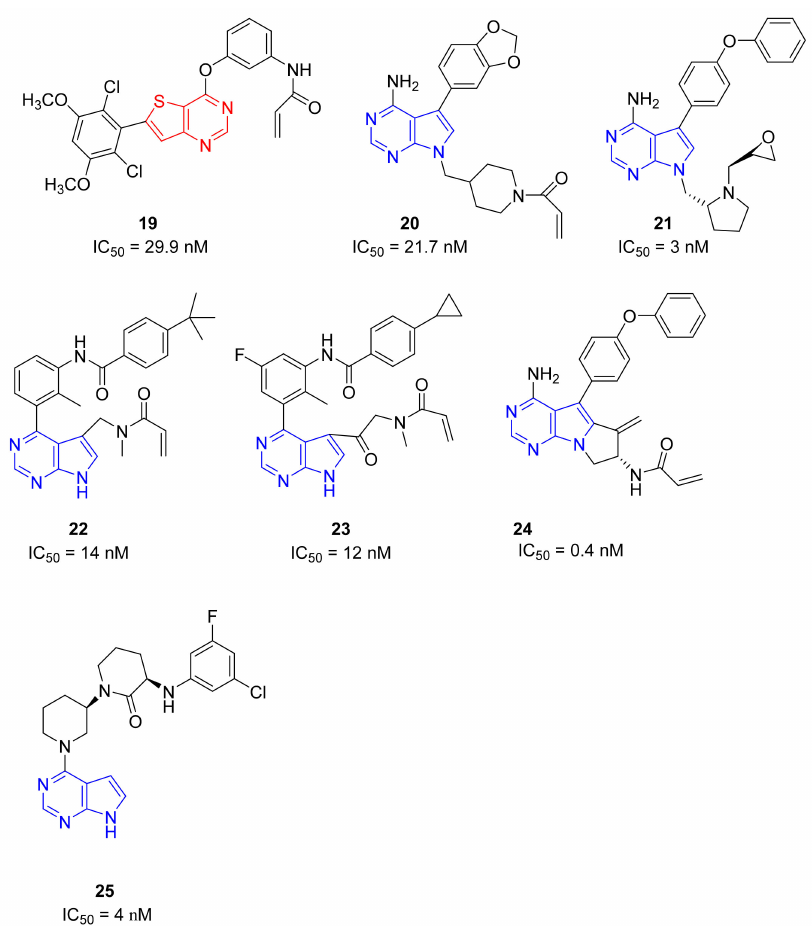
Figure 8. Thieno and pyrrolo-pyrimidine